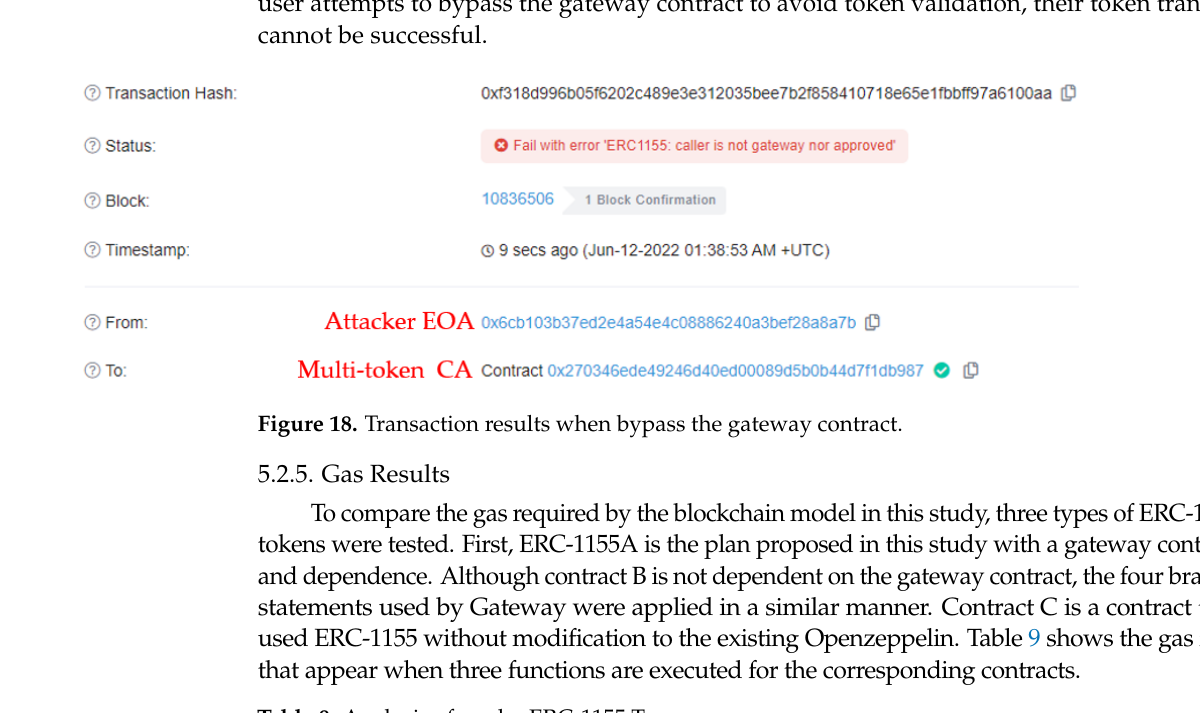
Table 9. Analysis of gas by ERC-1155